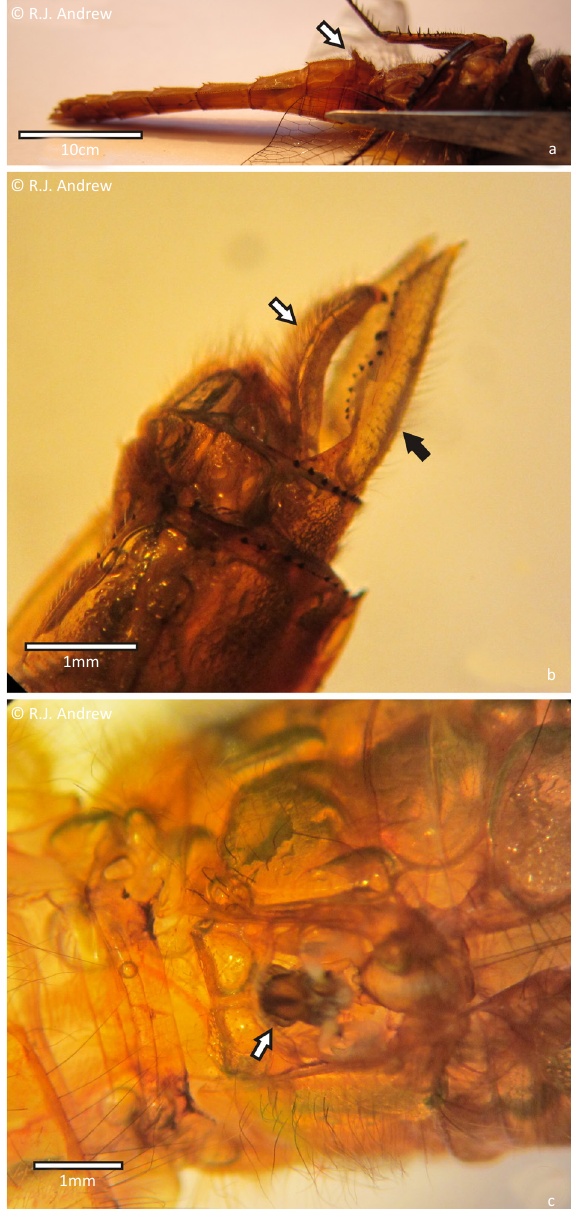
Image 2. Details of the collected Rhodothemis rufa male. a - Male secondary copulatory apparatus (arrow) located at the anterior end of the abdomen; b - Supra anal (black arrow) and infra anal (white arrow) appendages; c - Penis of the secondary copulatory apparatus